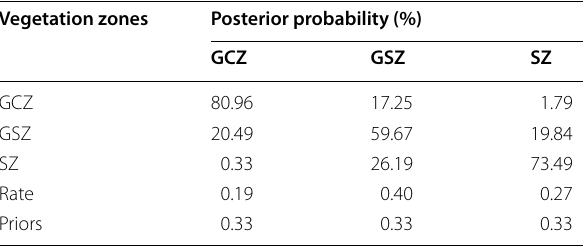
explained, respectively, (91.06%) and (100%) of the total variation. The right-hand side of the plot shows a close linkage of the GSZ zone with goats that have erected/ Table 4 Percent of individual goats classified into vegetation zones ( n 2114) = diagonal